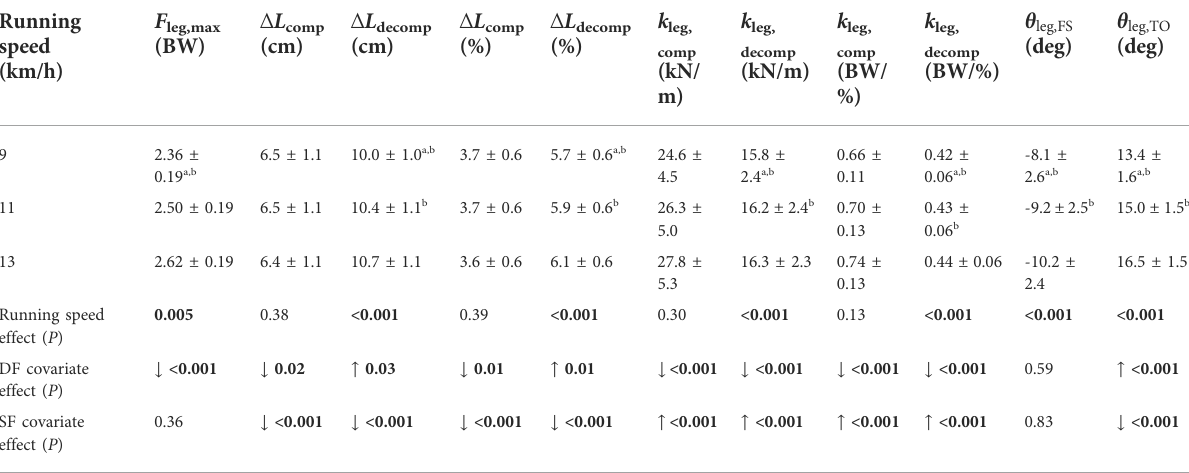
TABLE 5 Stiffness variables for runners at endurance running speeds. Signi fi cant differences ( P ≤ 0.05) identi fi ed by linear mixed effects modeling are indicated in bold. Running